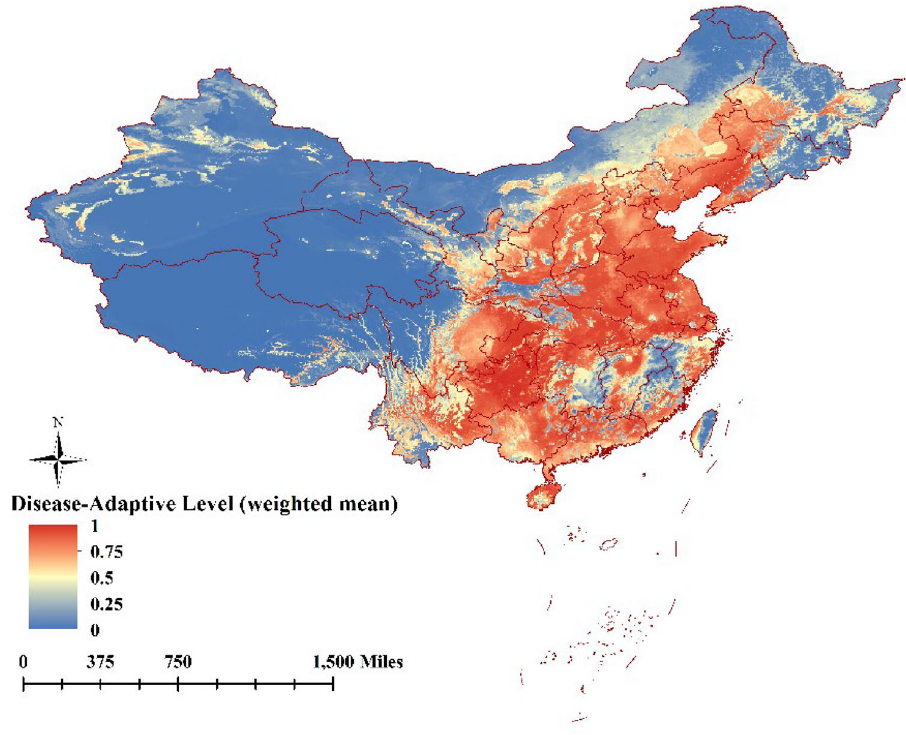
Figure 4. The disease-adaptive level of the ensemble model was expressed as the weighted mean suitable (The map is made by ArcGIS10.2 https:// www. esri. com/ and R 4.1.3 software https:// mirro rs. bfsu. edu. cn/